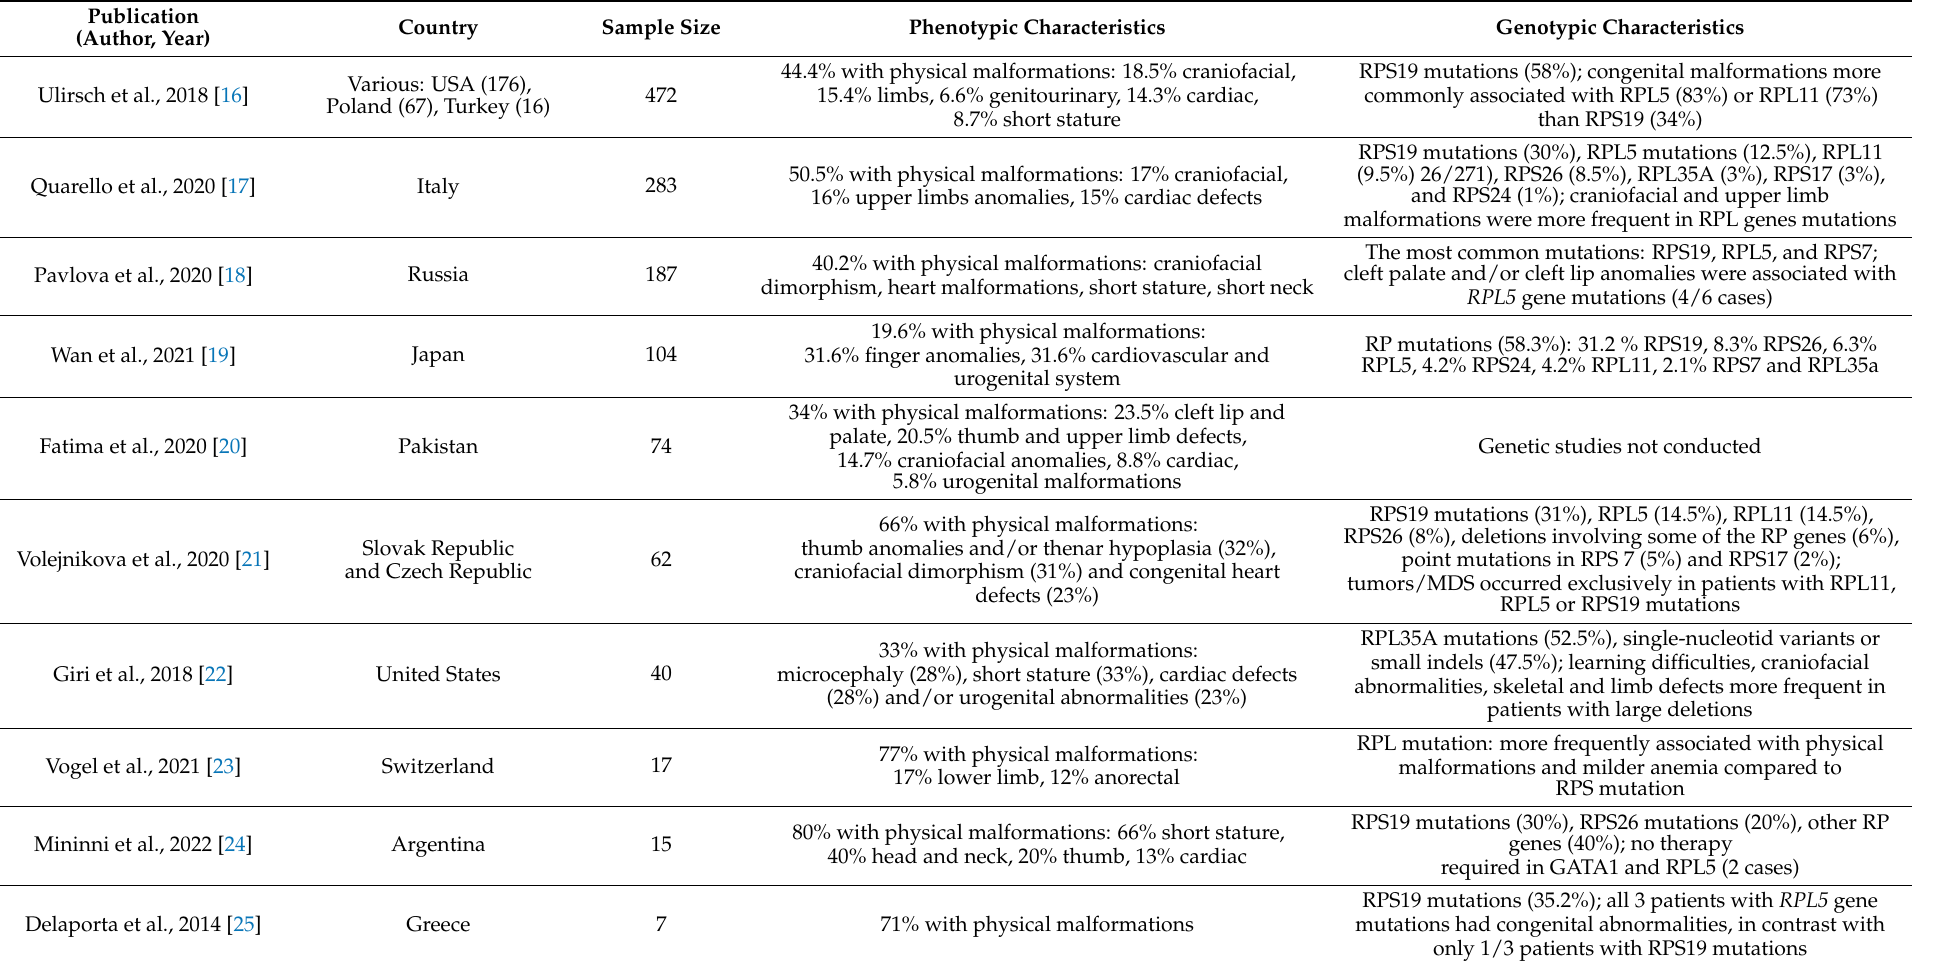
Table 1. Phenotypic and genotypic profile in DBA reported